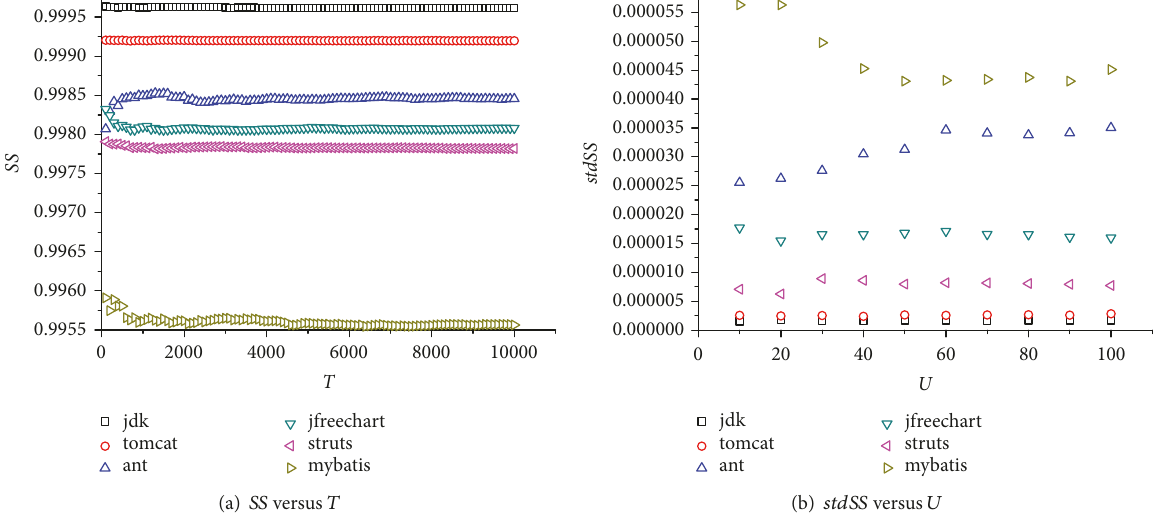
Figure 6: Illustration of 𝑆𝑆 versus 𝑇 and 𝑠𝑡𝑑𝑆𝑆 versus 𝑈